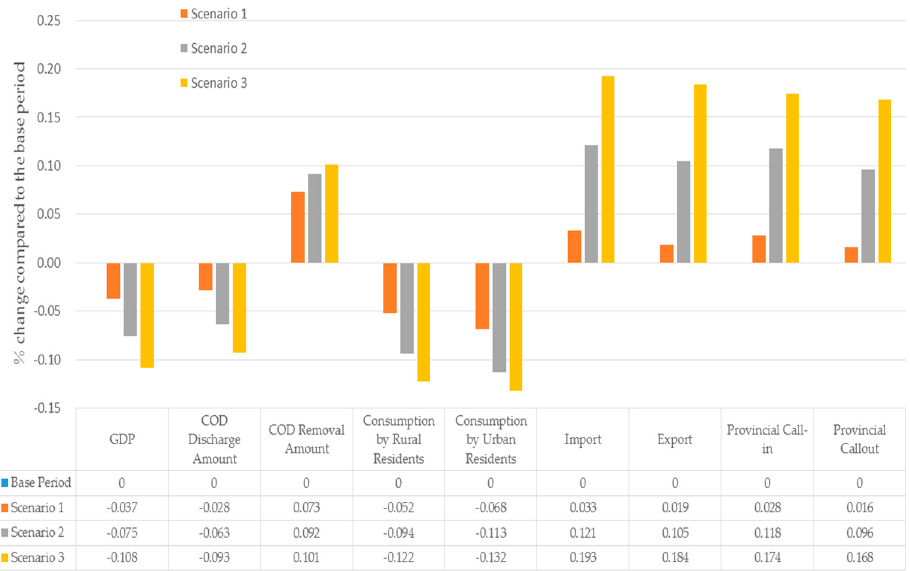
Figure 2. The overall economic impacts of increases in discharge fees.